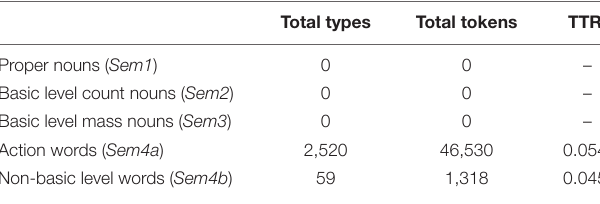
TABLE 4 | Total number of non-nouns in each semantic